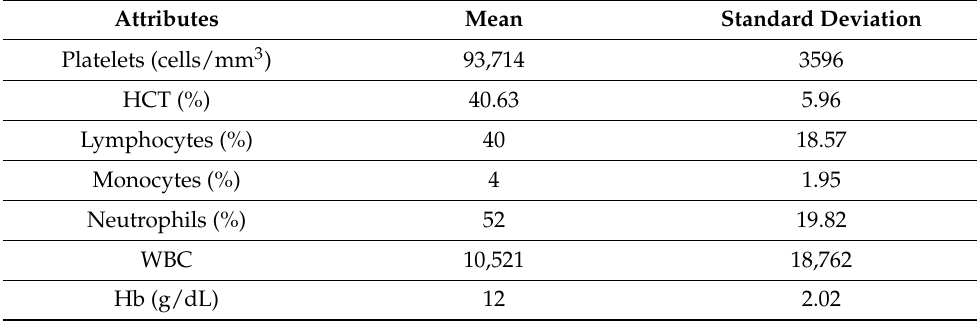
Table 7. Mean and standard deviation of different features for cluster 1.